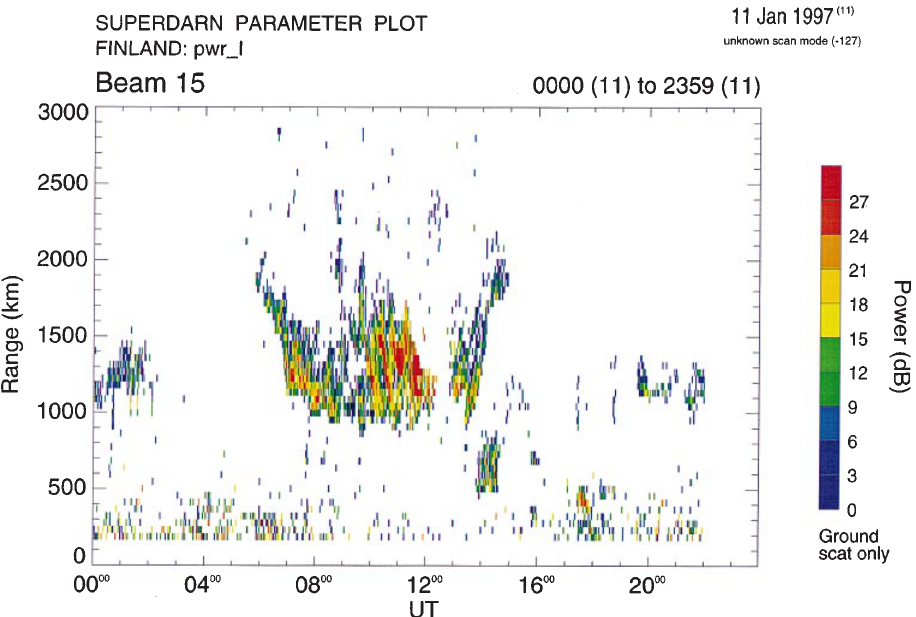
Fig. 2. Ground-scattered ‘back- ward-looking’ power returns from the Finland radar on the 11 January, 1997 for the beam closest